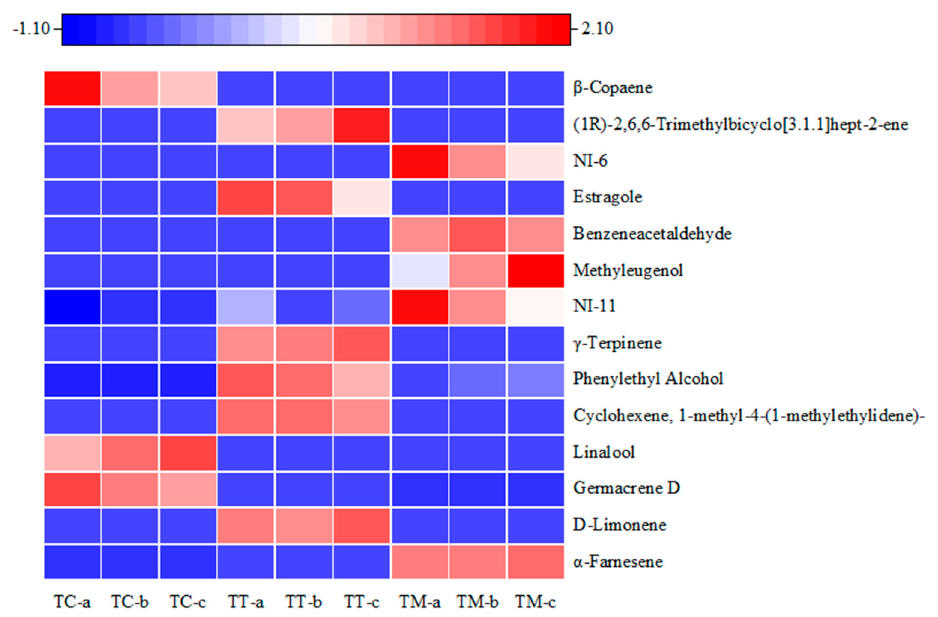
Figure 5. Heat map of content distributions about 14 crucial components in the three species from Tilia .